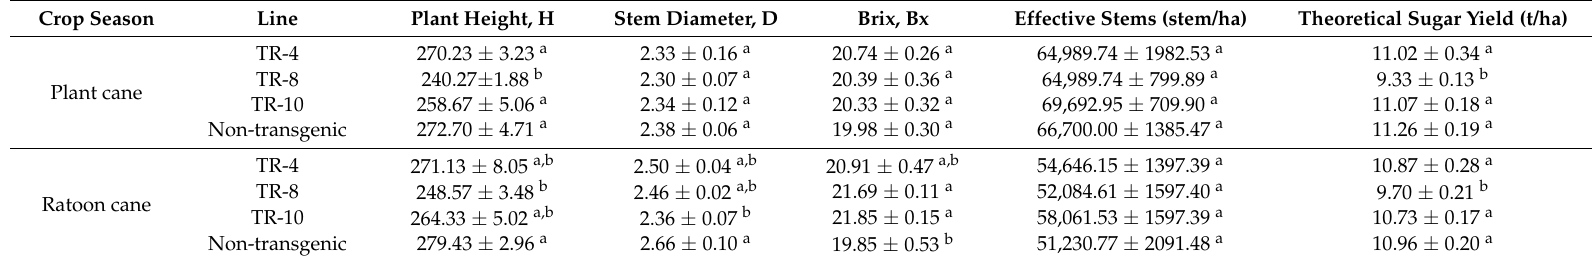
Table 2. Industrial and agronomic traits of different cry2A transgenic sugarcane lines during the plant and ratoon